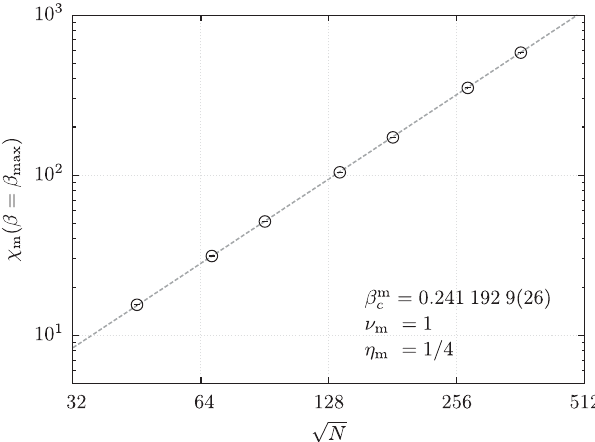
ffiffiffiffi p N . The data